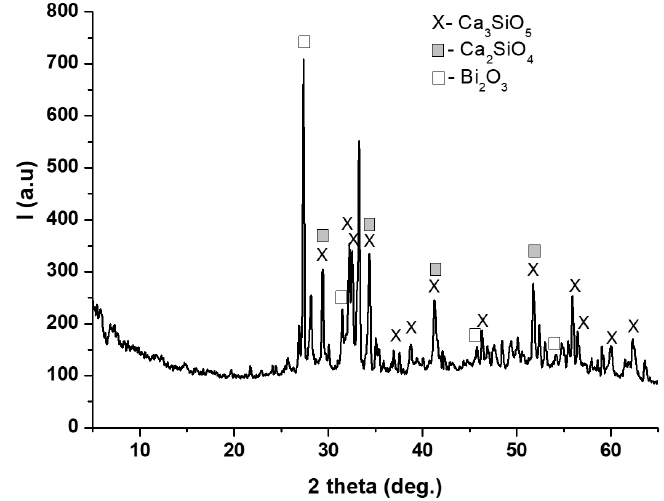
Figure 3. XRD patterns for anhydrous BIO MTA+ powder .